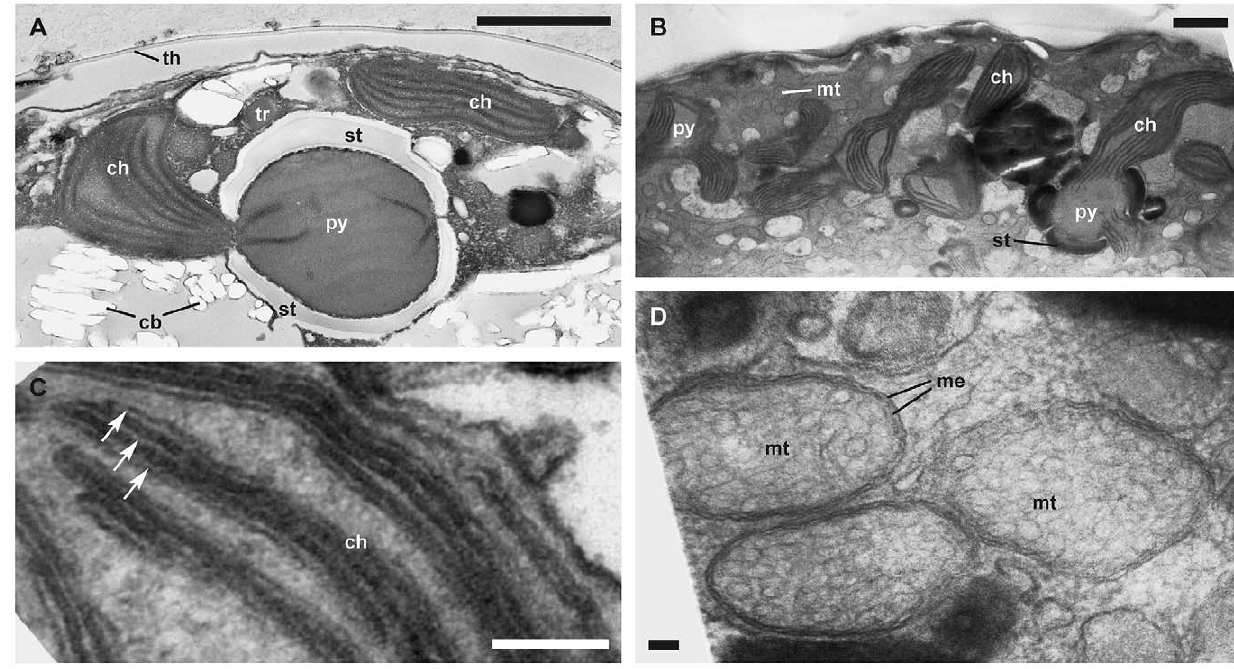
Figure 3. Ultrastructural traits in detail. (TEM). A. Multiply-stalked pyrenoid covered by a starch shed of Calciodinellum aff. operosum (GeoB 34, note the large, vacuolar crystal-like particles). B. Different chloroplast types of Scrippsiella bicarinata (GeoB 411, note that chloroplasts could be connected to multiply-stalked pyrenoids covered by a starch shed, or have interlamellar pyrenoids, with thylakoid lamellae leading through the pyrenoid. C. Two to four thylakoid lamellae (arrows) of Scrippsiella bicarinata (GeoB 411). D. Mitochondria with tubular cristae of Scrippsiella aff. trochoidea (GeoB 283). Abbreviations: ch, chloroplast; cb, crystal-like particle; me, membrane; mt, mitochondrion; py, pyrenoid; st, starch grain; tr, trichocyst. Scale bars: A and B 1 m m, C and D 0.1 m m.